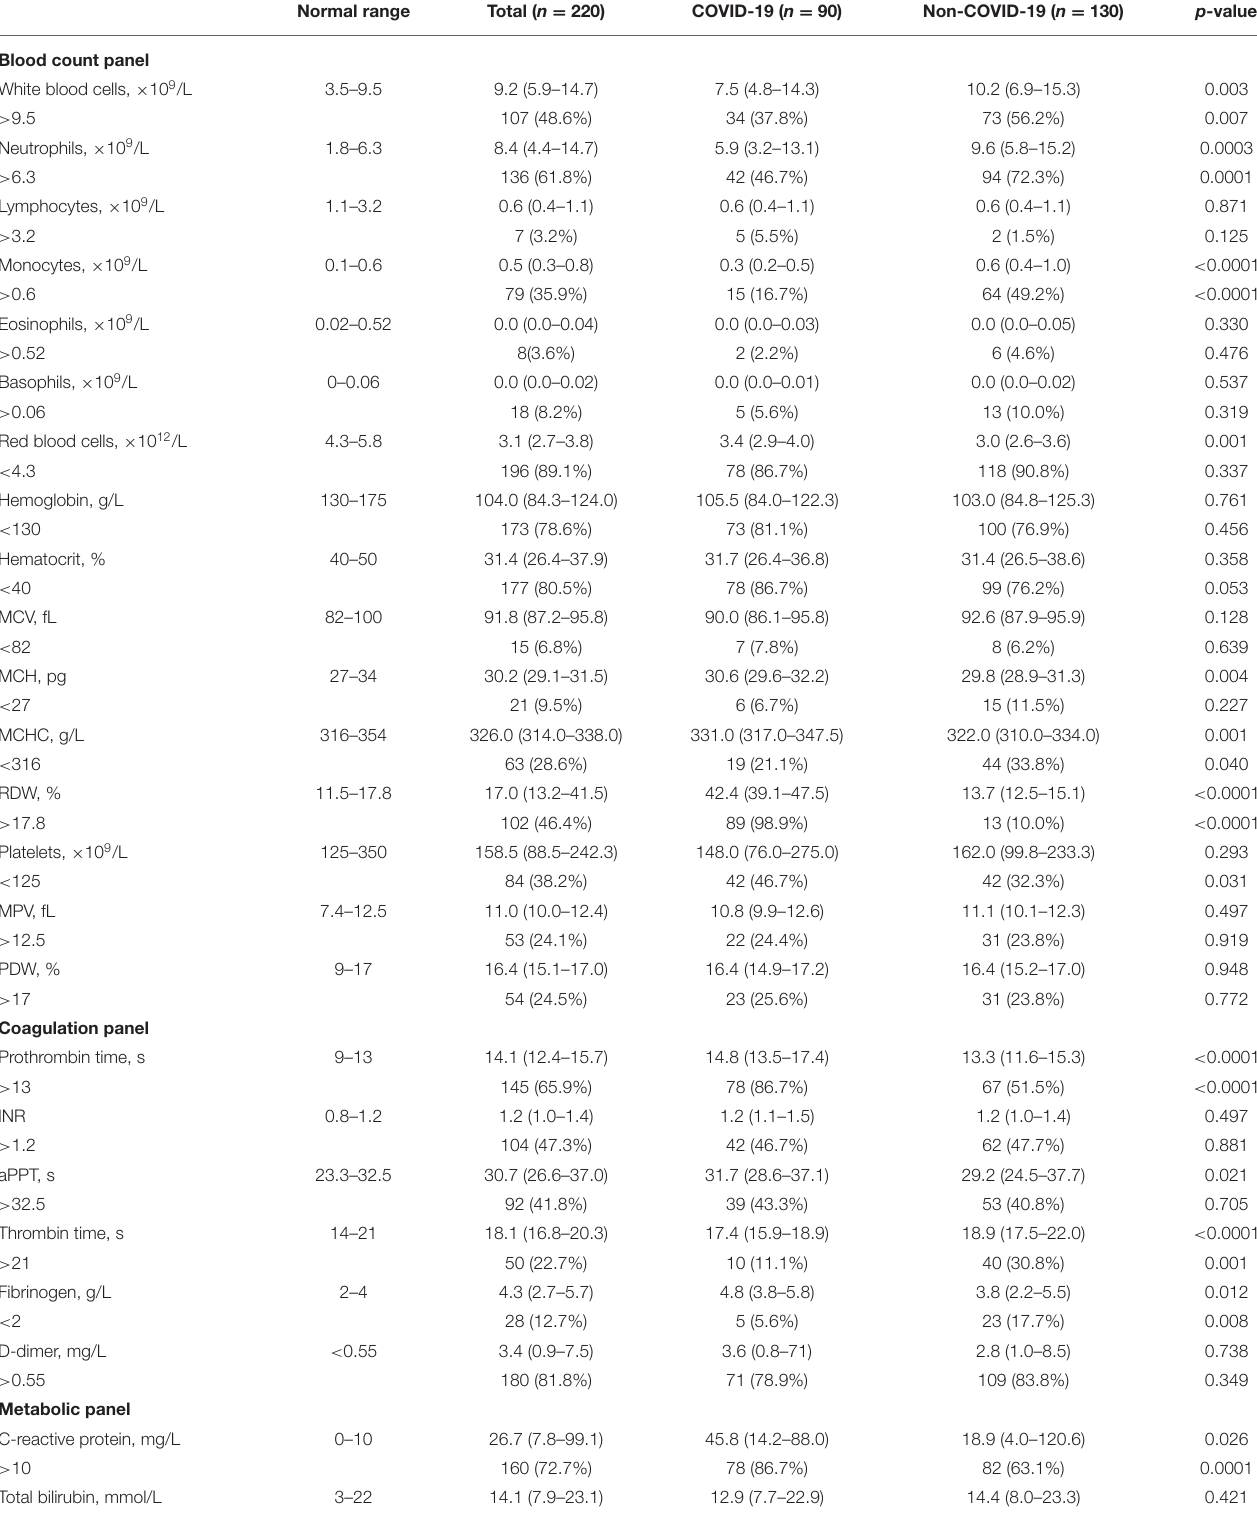
TABLE 2 | Laboratory testing results of ALI patients in the COVID-19 and non-COVID-19 cohorts. Normal range Total ( n = 220) COVID-19 ( n =